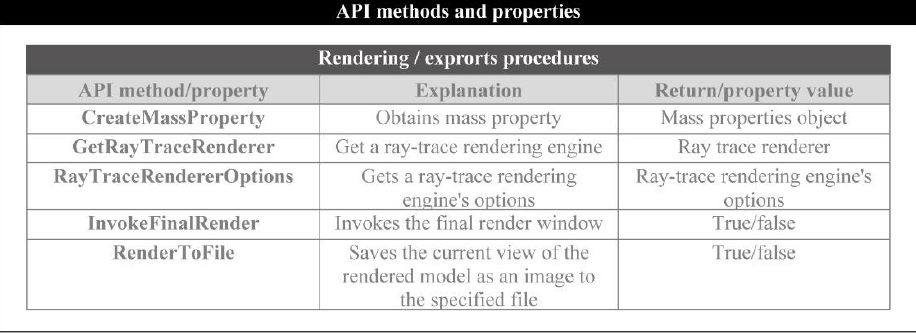
Figure 7. Code sample and algorithm flowchart used. As soon as the user selects a model number, an algorithm (Figure 7) performs a check on the shape of the table so that the geometric measurements can be applied accordingly. If the user inputs dimensions that correspond to a rectangle or a square, the algorithm uses the corresponding API method to generate a rectangle or a square using the diagonal